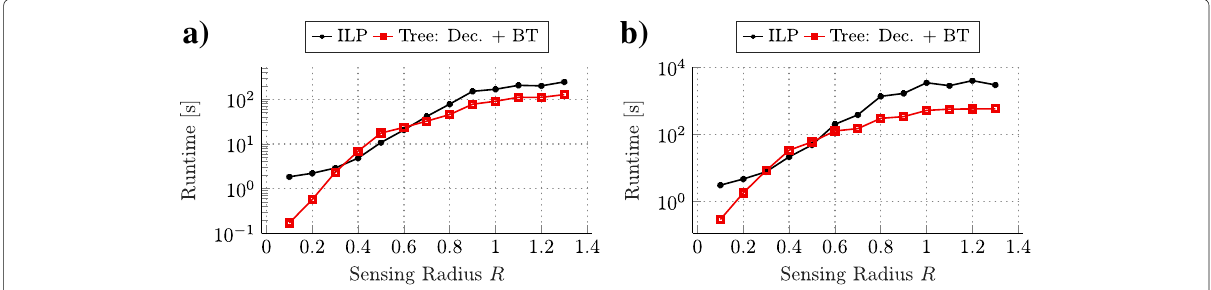
Fig. 8 Figures a and b show the total run times for 10 DS-CDMA codes in the case of N = 40 agents and 20 CD-CDMA codes for N = 80 agents. Moreover, the measurement noise has been set to σ =